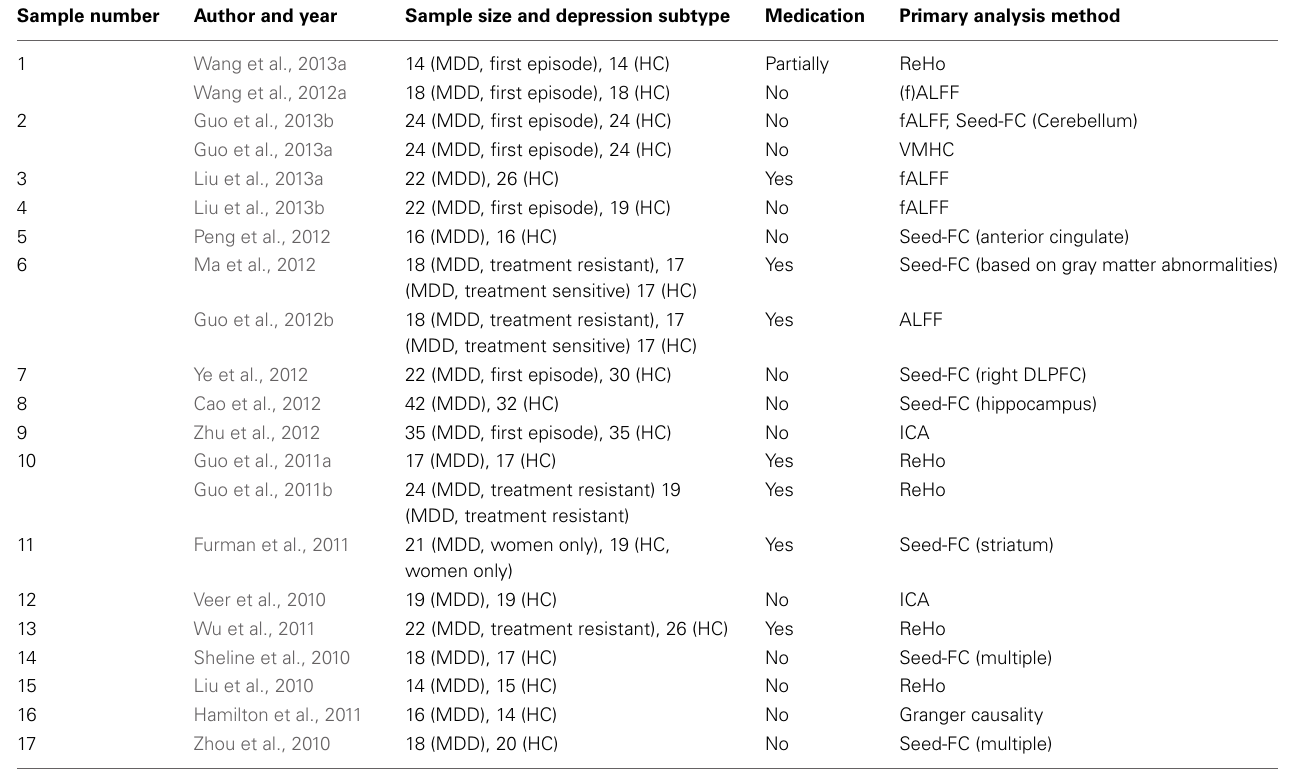
Table 2 | Studies in group B (representing mainly increased connectivity/function in